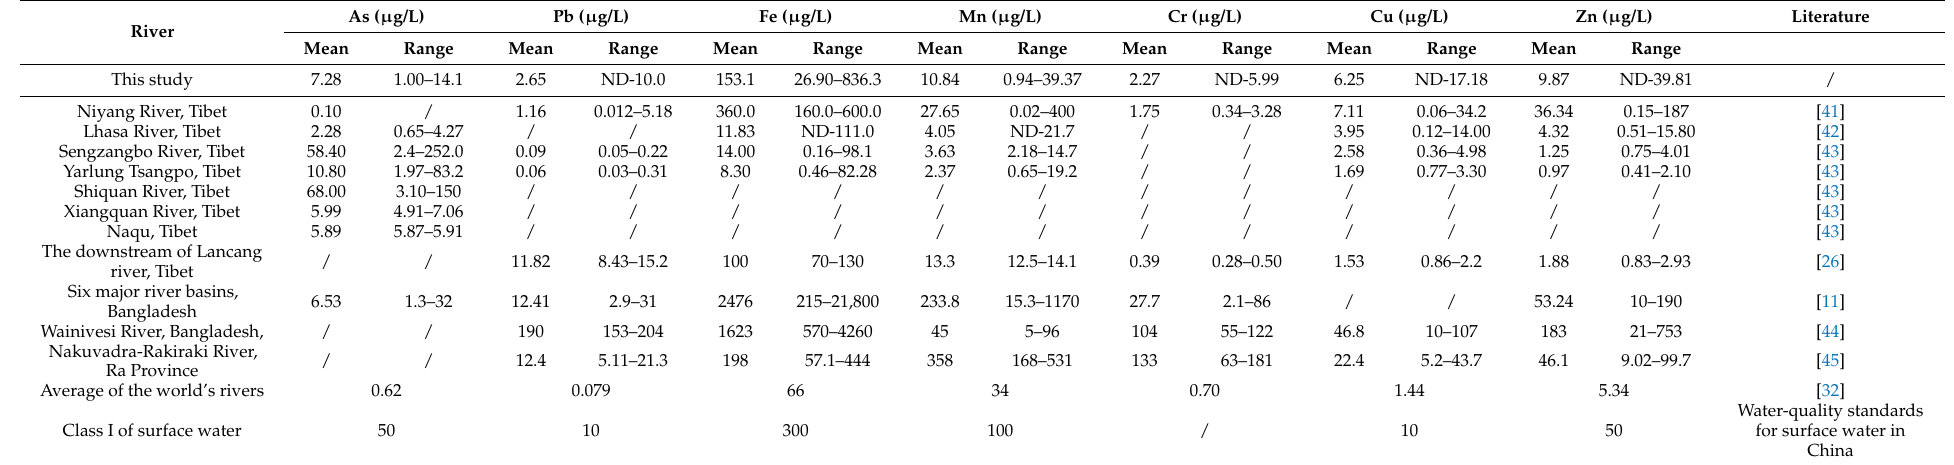
Table 4. Trace elements in